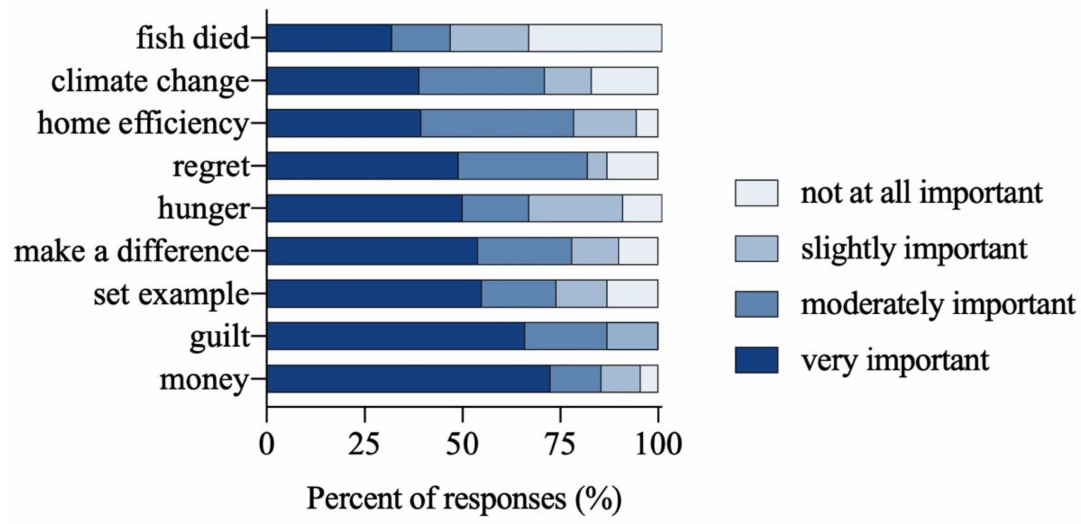
Figure 1. Motivations for reducing seafood discards from a post-seafood diary exit survey ( n = 42